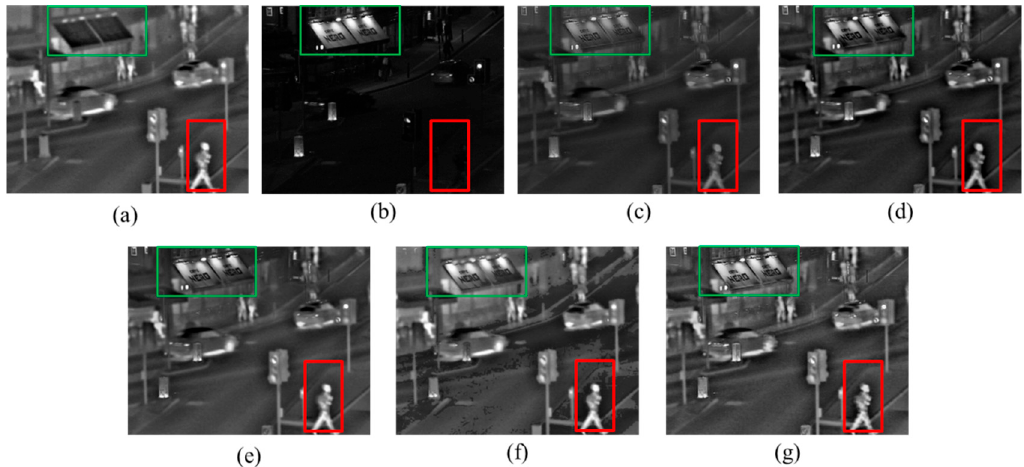
Figure 6. Quad image fusion comparisons: ( a ) IR image; ( b ) Visible image; ( c ) discrete wavelet transform (DWT) [12]; ( d ) PCA-MST [22]; ( e ) guidance filter (GFF) [24]; ( f ) IHS-PCNN [23]; ( g ) The proposed method.